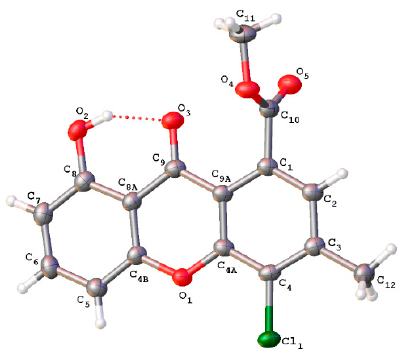
Figure 3. ORTEP view of methyl 8-dihydroxy-3-methyl-4-chloro-9-oxo-9H-xanthene-1-carboxylate ( 1 ), showing atomic labeling. Displacement ellipsoids are drawn at the 30% probability level.